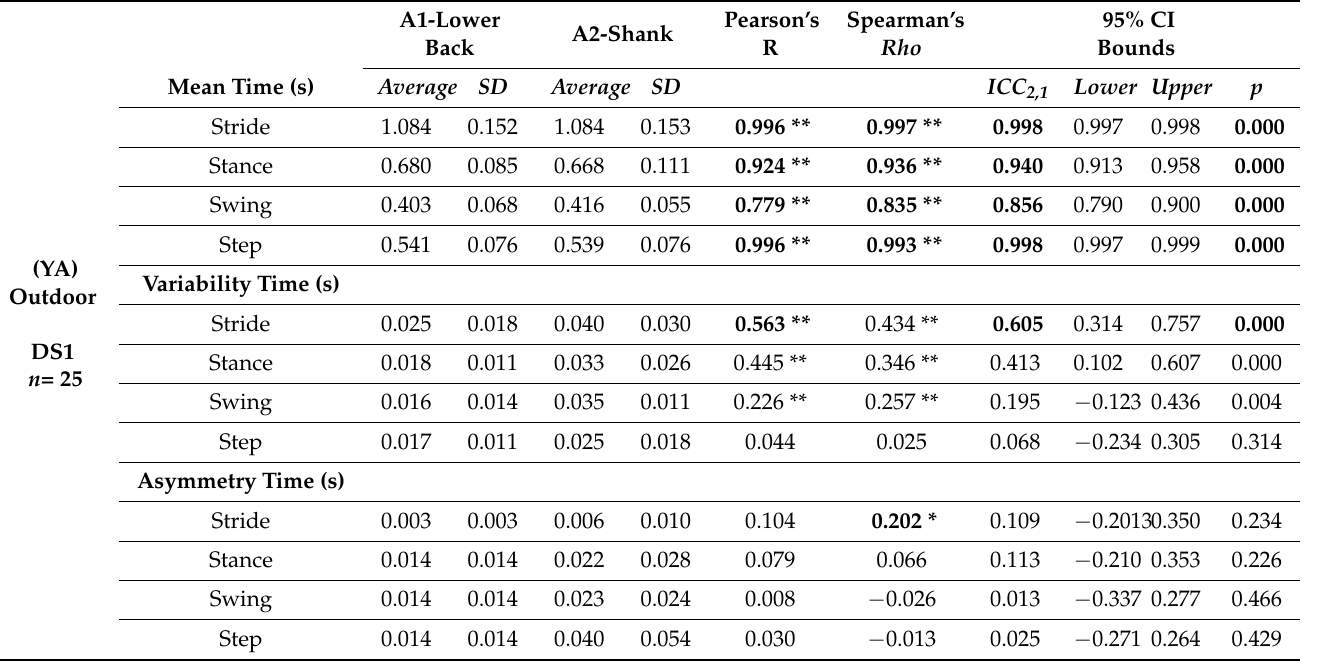
Table 4. Extracted temporal parameters and agreements for outdoor